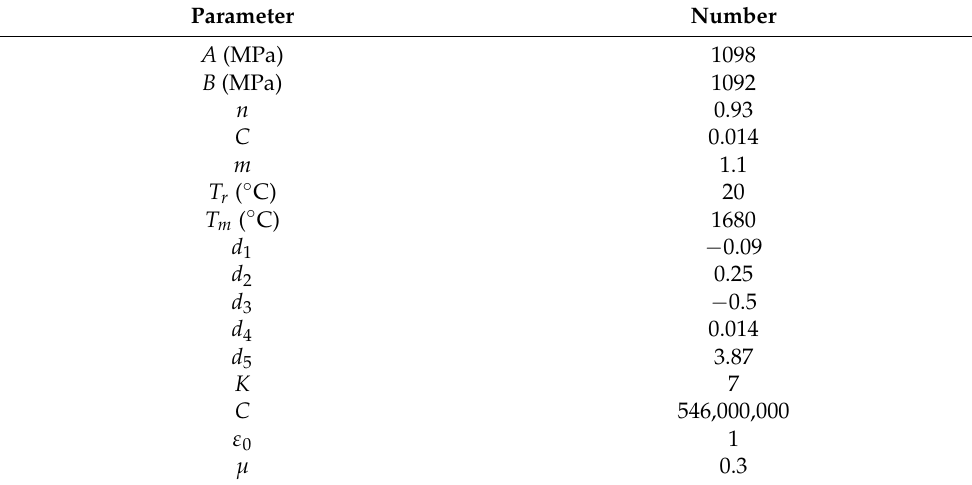
Table 1. Workpiece parameter